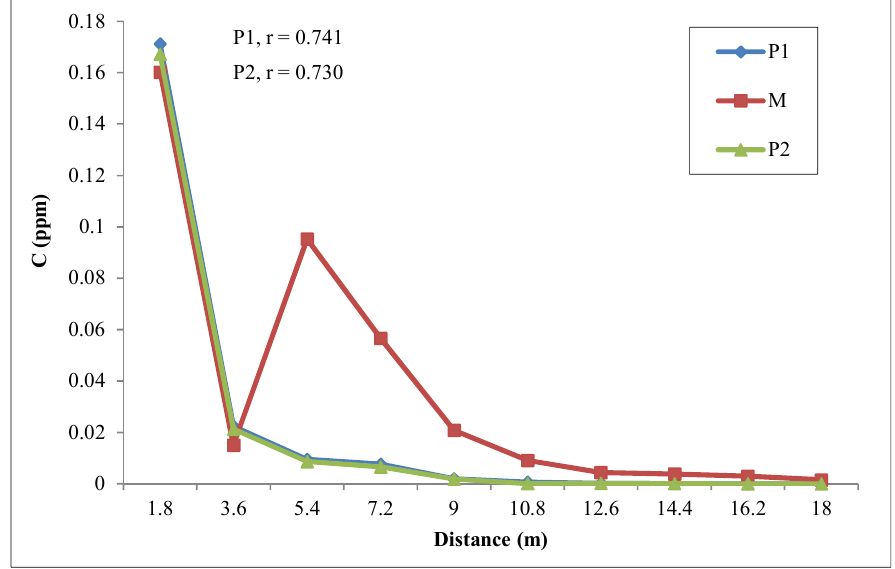
Figure 12. Measured and Predicted Concentrations against Distance for the month of